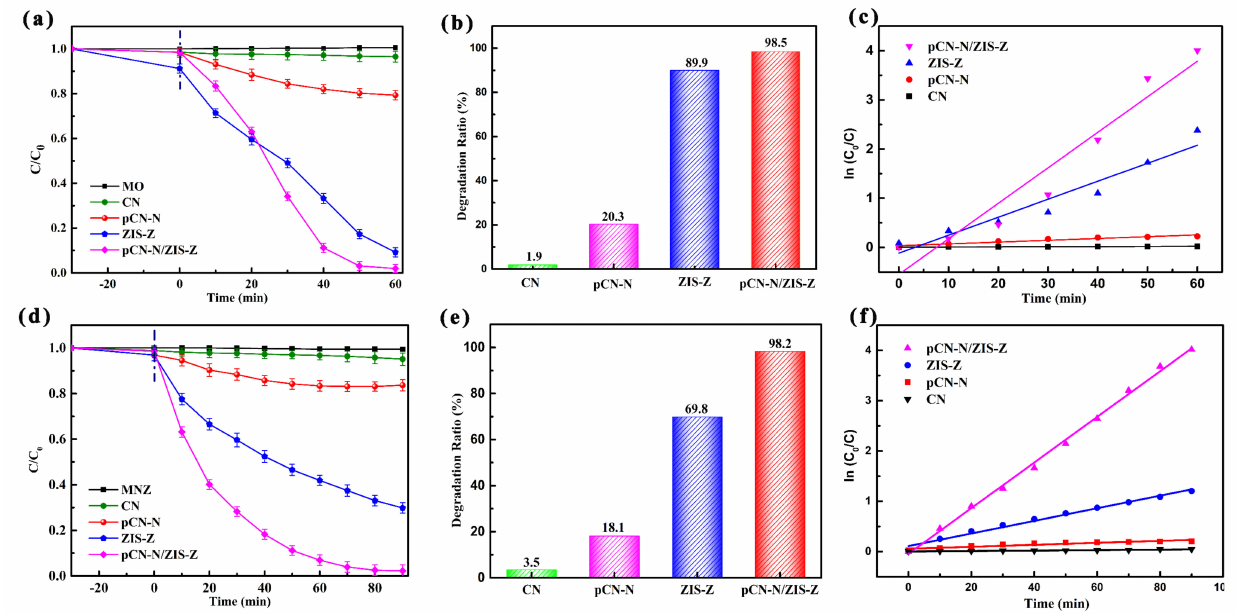
Figure 7. Photocatalytic activities of CN, pCN-N, ZIS-Z and pCN-N/ZIS-Z toward the degradation of MO ( a – c ), MNZ ( d – f